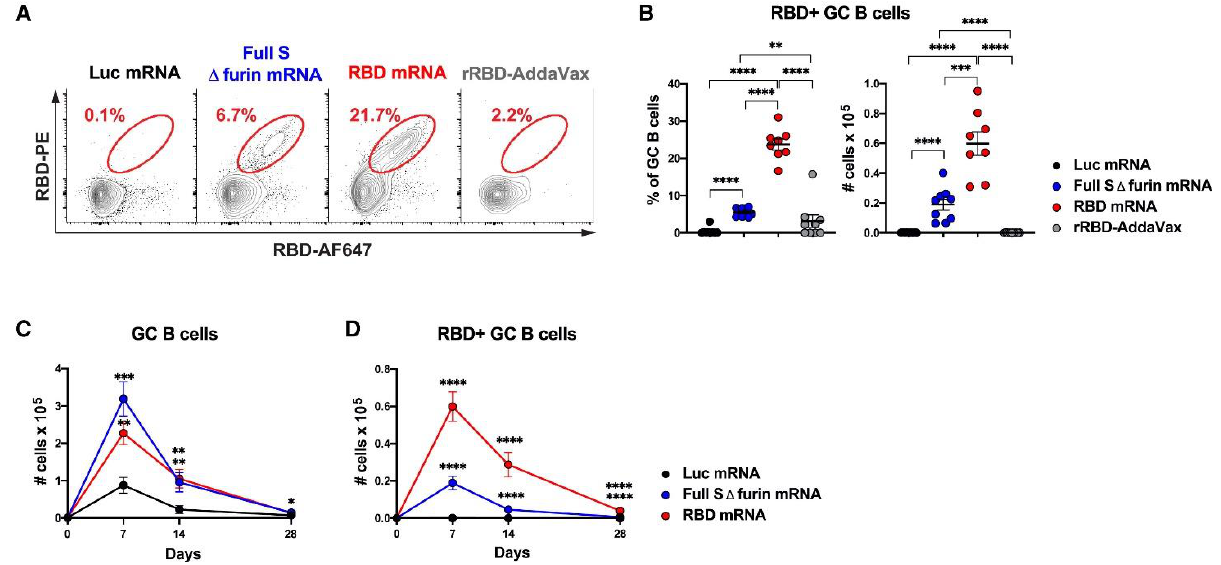
Figure 3. Antigenic response after intravenous administration of SARS-CoV-2 mRNA vaccine. ( A ) Flow cytometry counts of RBD-specific GC B cells. ( B ) Frequency and absolute number of cells after 7 days of immunization. ( C ) Kinetics of the absolute number of cells. ( D ) Curves of absolute cell numbers versus time [135]. * p ≤ 0.05, ** p ≤ 0.01, *** p ≤ 0.001, **** p ≤ 0.0001.